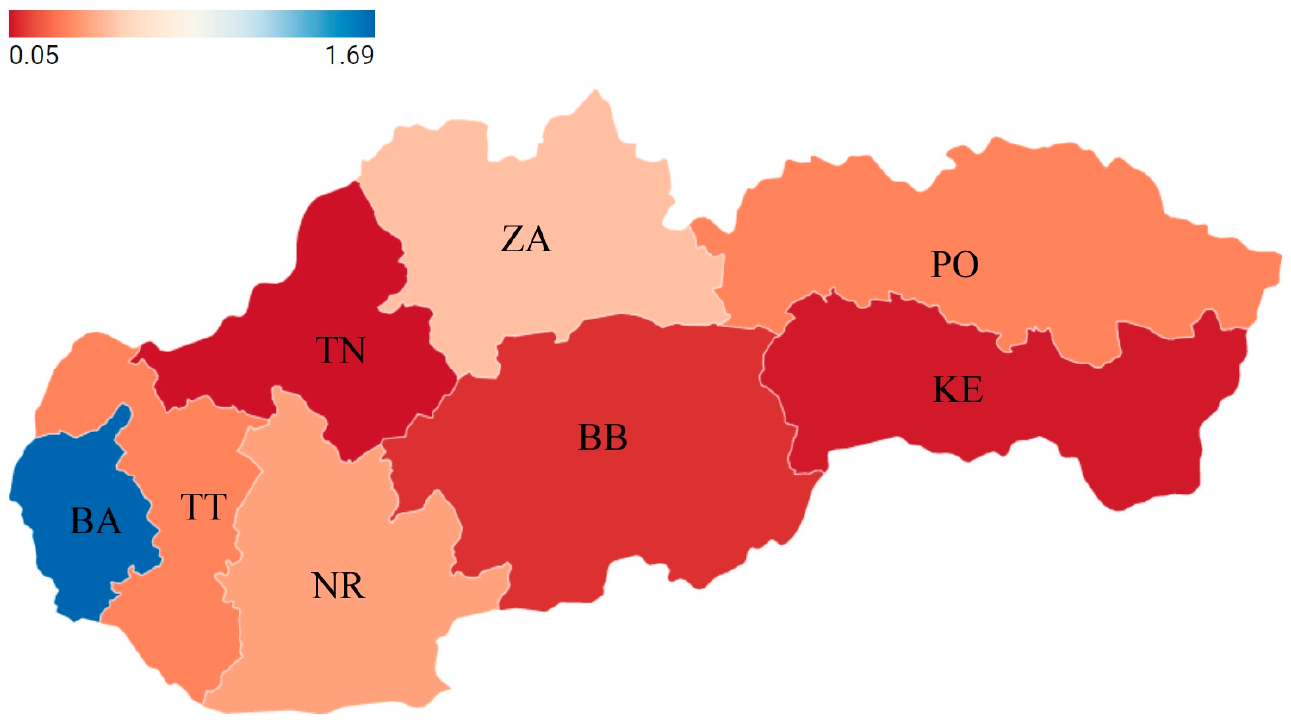
Figure 2. Graphical evaluation of ERI CO values during the years 2014–2019. Own processing. The values from 2016 to 2019 are positive. This result means that enterprises in this region can increase their revenues by decreasing, especially in the case of constantly pro- duced carbon monoxide emissions.